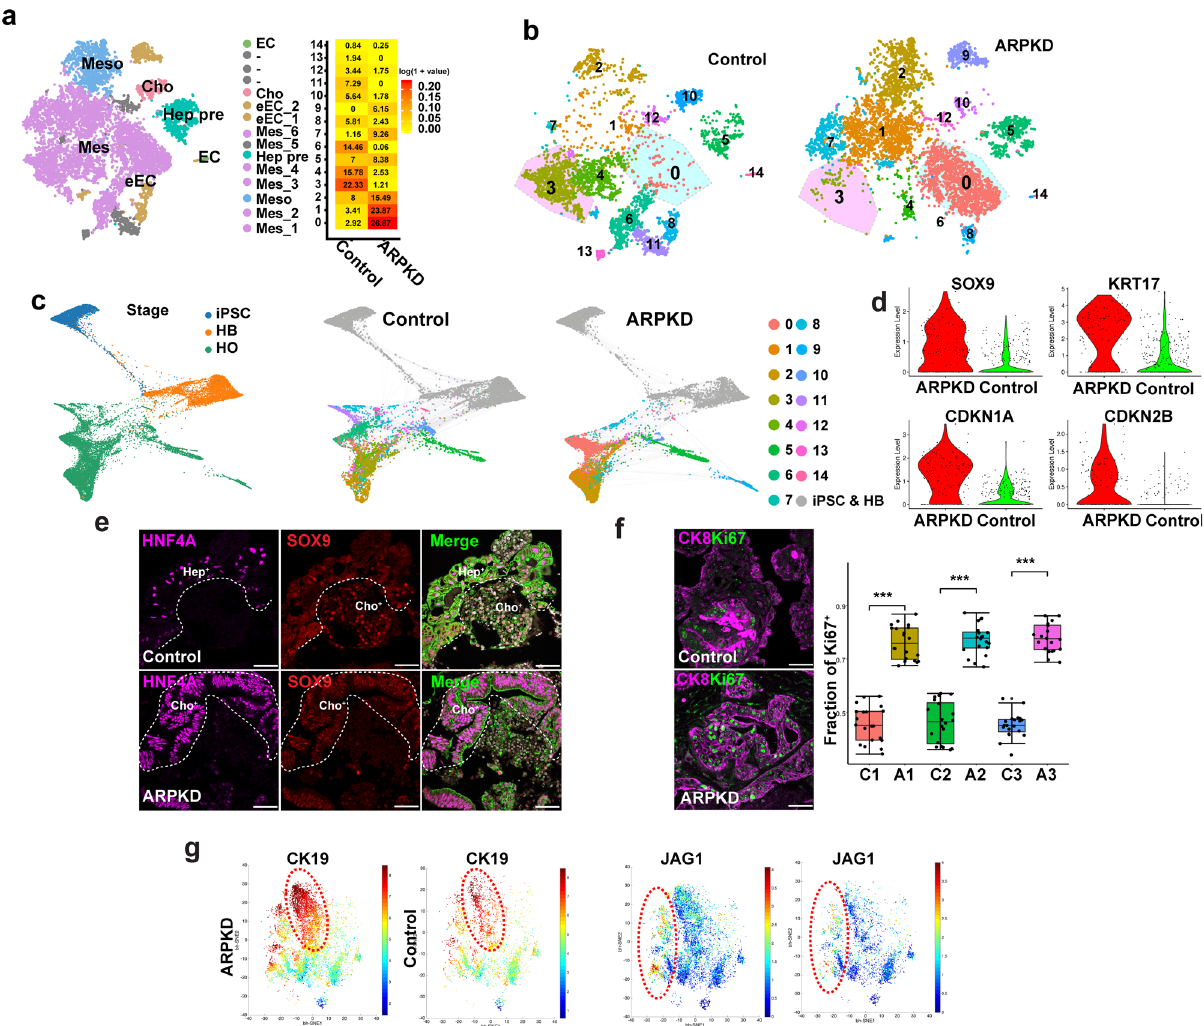
Fig. 4 scRNA-Seq analysis of HOs. a A combined t-SNE plot of the ARPKD and control organoid scRNA-Seq data shows the cell types within the 15 different clusters identi fi ed by k-nearest neighbor analysis, which include: various types of mesenchymal cells (Mes; clusters 0, 1, 3, 4, 6, 7), mesothelia (Meso; cluster 2), hepatocyte precursors (Hep pre; cluster 5), early endothelia (eEC, clusters 8, 9), cholangiocytes (Cho; cluster 10), and endothelia (EC; cluster 14). The heatmap compares the percentages of cells within each cluster present in control and ARPKD organoids. The colors represent the log- transformed percentage of cells within each cluster. The cell types are listed in Table S1 and were annotated as described in Table S2. b t-SNE plots separately show the 15 clusters identi fi ed in control and ARPKD organoids. c The developmental trajectories of ARPKD and isogenic control cells are similar at the iPSC (day 0) and hepatoblast (HB, day 9) stages, but differ signi fi cantly at the organoid (day 21) stage. The left graph shows the cells in ARPKD and isogenic control cultures at the iPSC, HB and hepatic organoid stages. The ARPKD and isogenic control cells are separately graphed (middle, right). Each cell cluster in the organoids is indicated by a color, while the iPSC and HB cells are gray. The ARPKD and isogenic control cells are very similar at the iPSC and HB stages, but signi fi cantly diverge at the organoid stage. As examples, clusters 0 and 1 are far more abundant in ARPKD than in control organoids; while clusters 3 and 4 are far more abundant in control organoids; and cluster 9 is present in ARPKD, but not in control organoids. d Violin plots show the increased level of expression of mRNAs for liver progenitor cell (SOX9, 2.1-fold; KRT17, 5.3-fold) and cell proliferation (CDKN1A, 3.2-fold; CDKN2B, 1.9-fold) markers in ARPKD relative to control cholangiocytes (cluster 10). e , f Control and ARPKD HOs were immunostained with antibodies to SOX9 and HNF4A or with anti-CK8 and anti-Ki67 antibodies. Scale bars are 50 μ m. The dashed lines separate areas with hepatocytes (Hep + ) or cholangiocytes (Cho + ) from other regions. The boxplot shows the fraction of Ki67 + cholangiocytes within 3 pairs of ARPKD and isogenic control HOs ( n = 20 per group, C1 vs A1 p < 2.22 × 10 − 16 , C2 vs A2 p = 2.4 × 10 − 16 , C3 vs A3 p < 2.22× 10 − 16 . *** p < 0.001). Box plots in f (center line, median; box limits, upper and lower quartiles; whiskers, 1.5 × interquartile range). g CK19 and JAG1 expression increased in ARPKD organoids. bhSNE maps of CyToF data generated using ARPKD and control HOs. The dotted circle shows the JAG1 + cell (Fig. 4a, Supplementary Table 1). Cluster identities were con- fi rmed by expression of canonical mRNA markers (Supplemen- tary Fig. 2e). To identify cells that could contribute to ARPKD